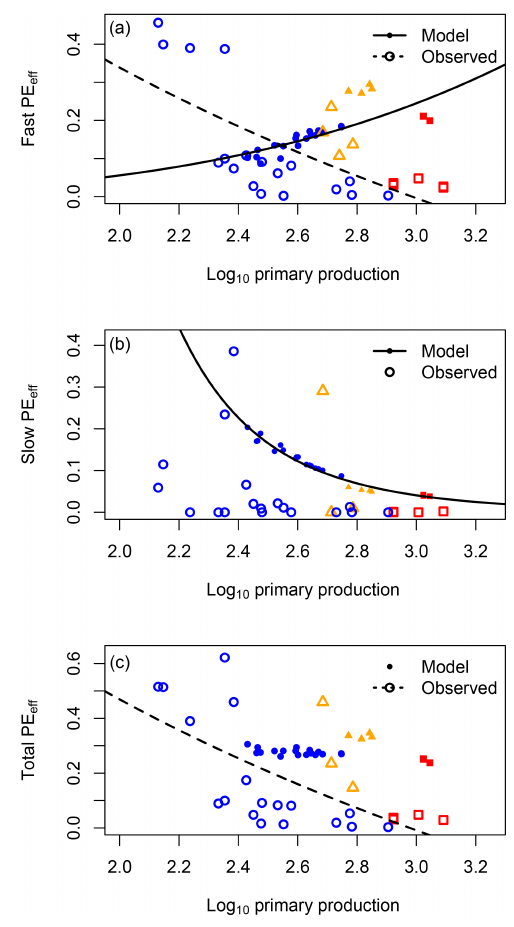
Figure 3. Primary production against particle export efficiency (PE eff ) for (a) fast sinking, (b) slow sinking, and (c) total sinking particles. Blue circles are Southern Ocean, red squares PAP, and or- ange triangles equatorial Pacific. Filled circles and solid black lines show model output and open circles and dashed lines are observa- tions. All fitted lines are statistically significant to at least the 95% level (see text for